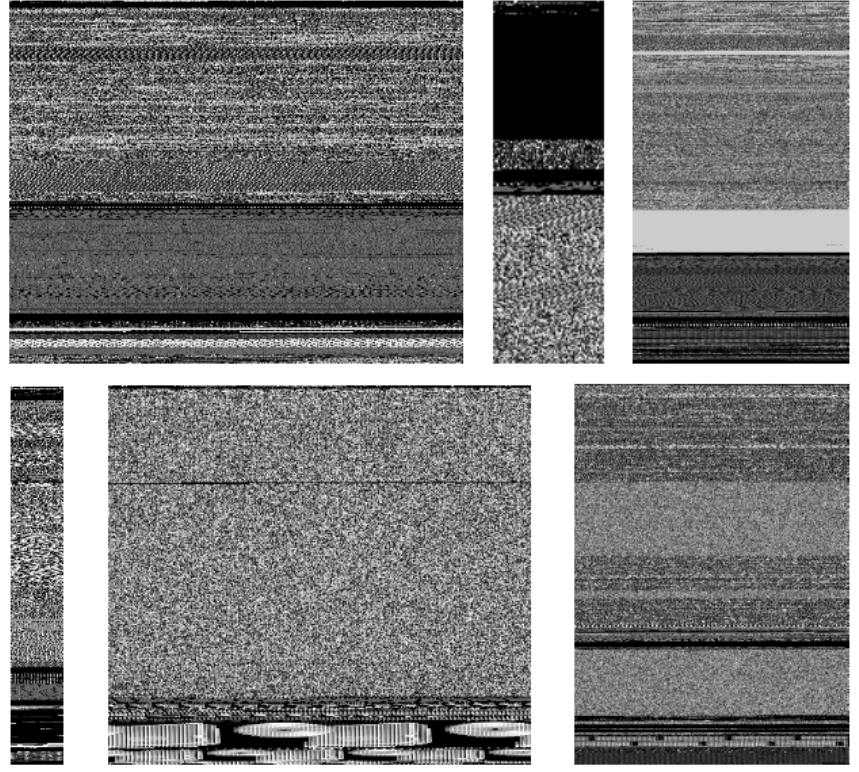
Figure 1. Representative visualized malware